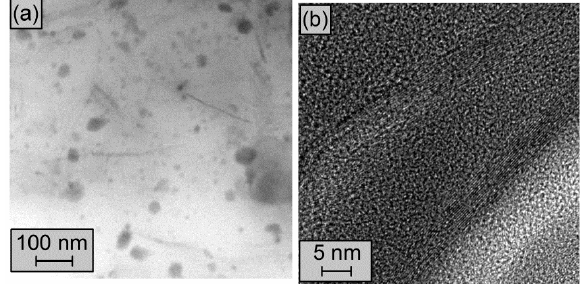
Figure 8. ( a ) and ( b ) TEM micrographs of CIIR/MLG3.